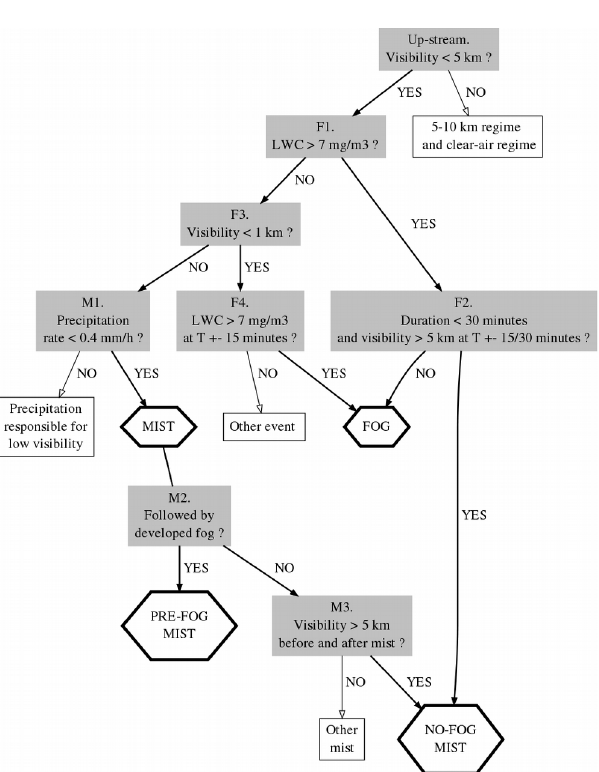
Figure 3. Flow chart of the pre-fog/no-fog mist and fog definitions, according to observations made at SIRTA in November 2011. This flow chart has to be applied every step of 15min. Criteria are ap- plied at the current time step (T) when not specified. Questions are showed in grey rectangles, and the four appropriate events in